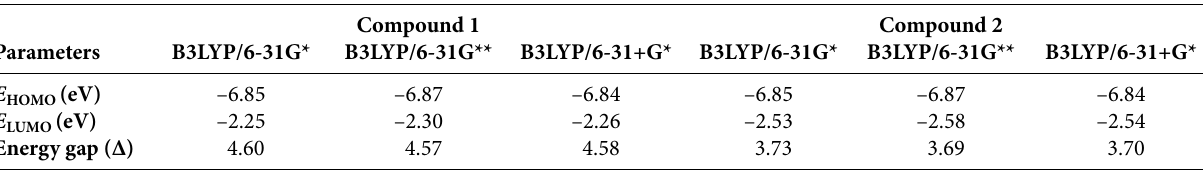
Table 4. Calculated HOMO and LUMO energy values for compounds 1 and 2 .